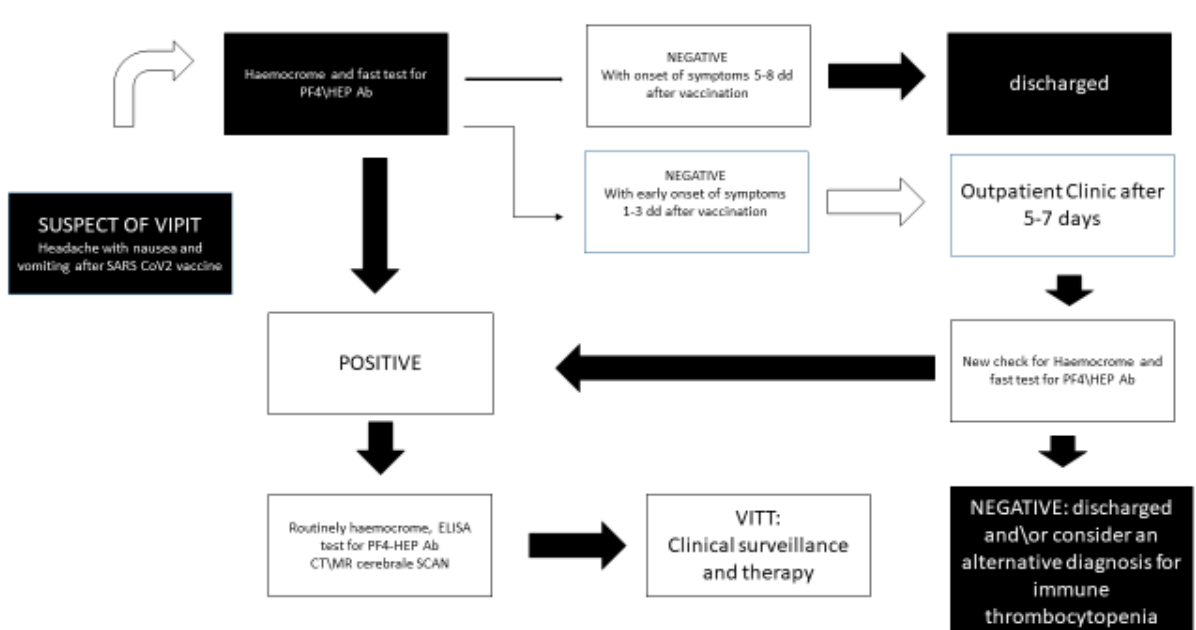
Figure 1. Flow chart to manage patients with suspected VIPIT\VITT at the emergency